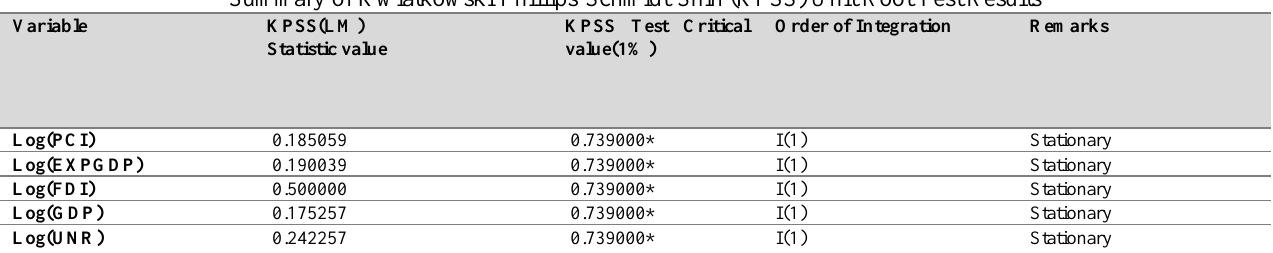
Summary of Kwiatkowski-Phillips-Schmidt-Shin (KPSS) Unit Root Test Results